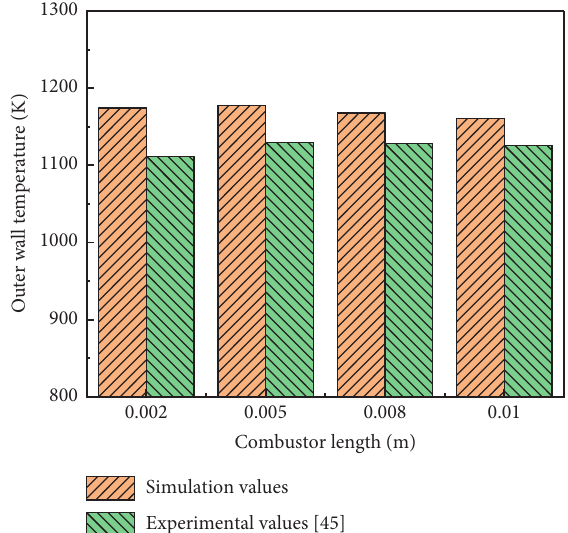
Figure 5: Comparison between simulated and experimental